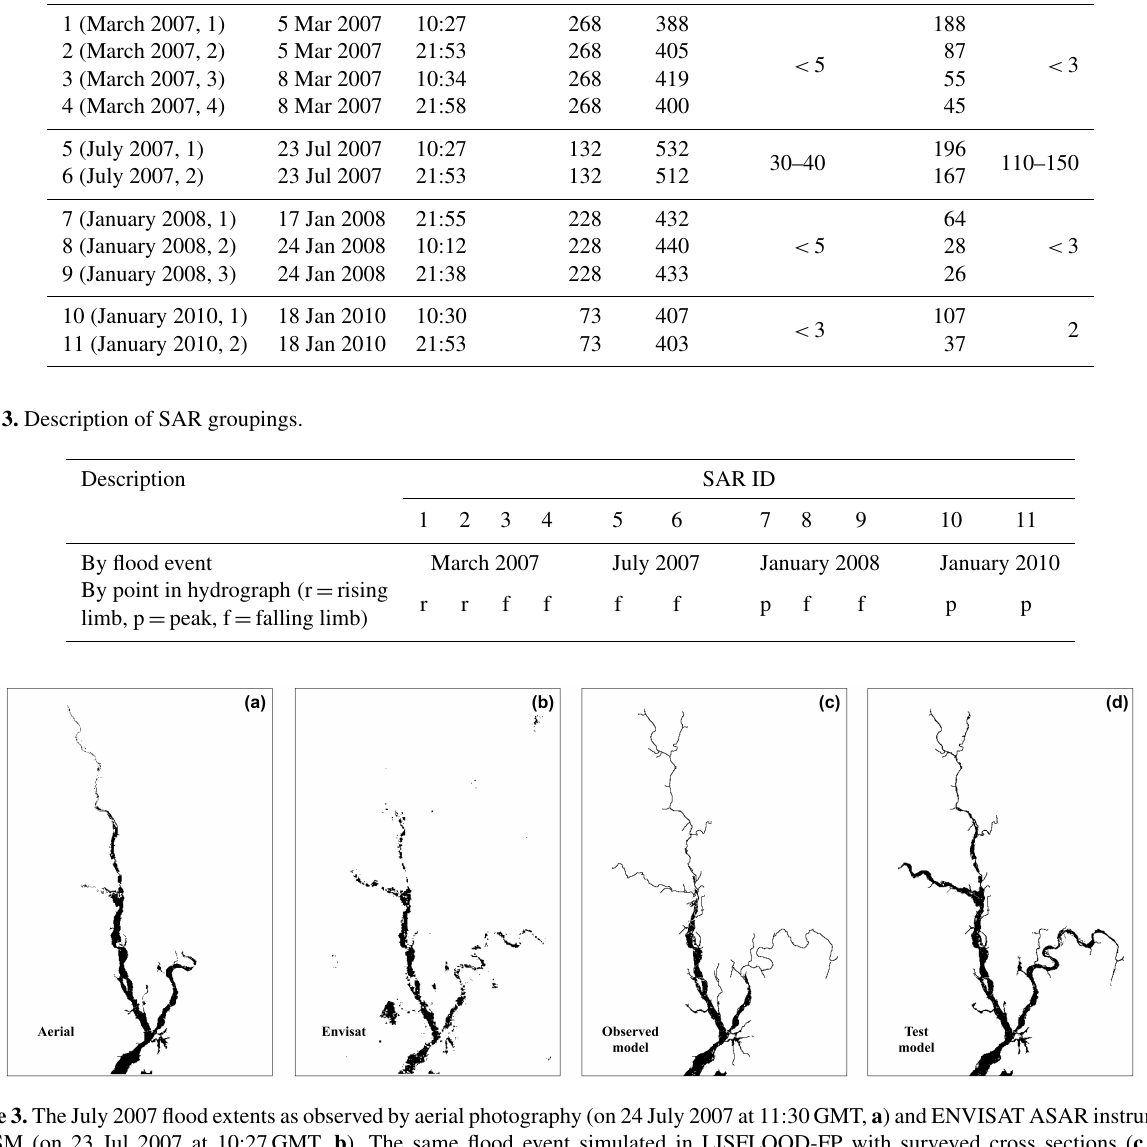
Figure 3. The July 2007 flood extents as observed by aerial photography (on 24 July 2007 at 11:30GMT, a ) and ENVISAT ASAR instruments in WSM (on 23 Jul 2007 at 10:27GMT, b ). The same flood event simulated in LISFLOOD-FP with surveyed cross sections ( c , with Manning’s channel roughness fixed at 0.038) and the test model with optimally calibrated parameters (d)